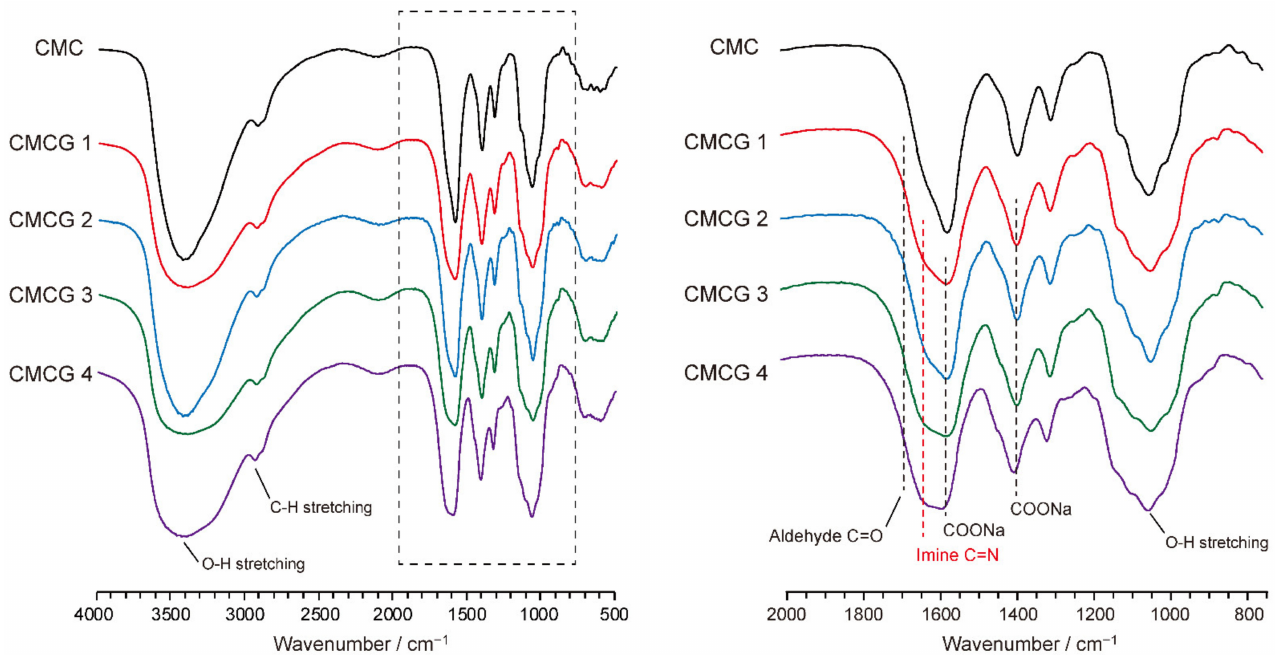
Figure 6. Full and expanded Fourier transform infrared spectra of CMCG 1–4 and